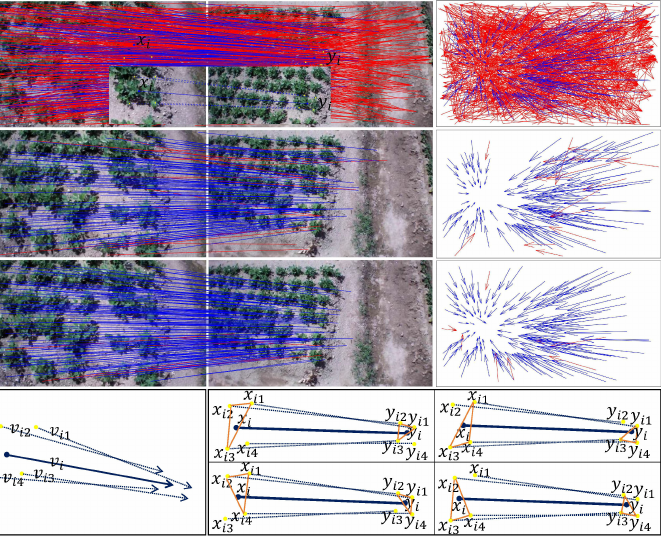
Figure 6. Comparison II of LPM and TAT: keep correct matching point pairs. SIFT algorithm initial matching result ( row 1 , left ); LPM algorithm matching result ( row 2 , left ); TAT algorithm matching result ( row 2 , left ); matching result vector cluster map( row 1 – row 3 , right ); schematic diagram of displacement vector of LPM algorithm ( row 4 , left ); and schematic diagram of affine model constraint of TAT algorithm ( row 4 , right